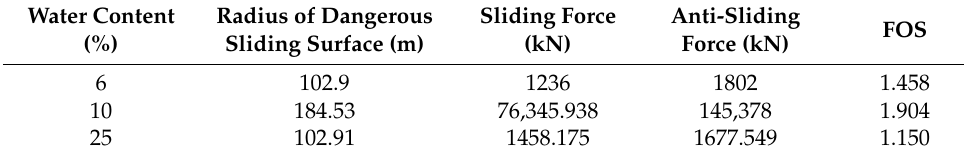
Table 7. Prediction results of FOS.